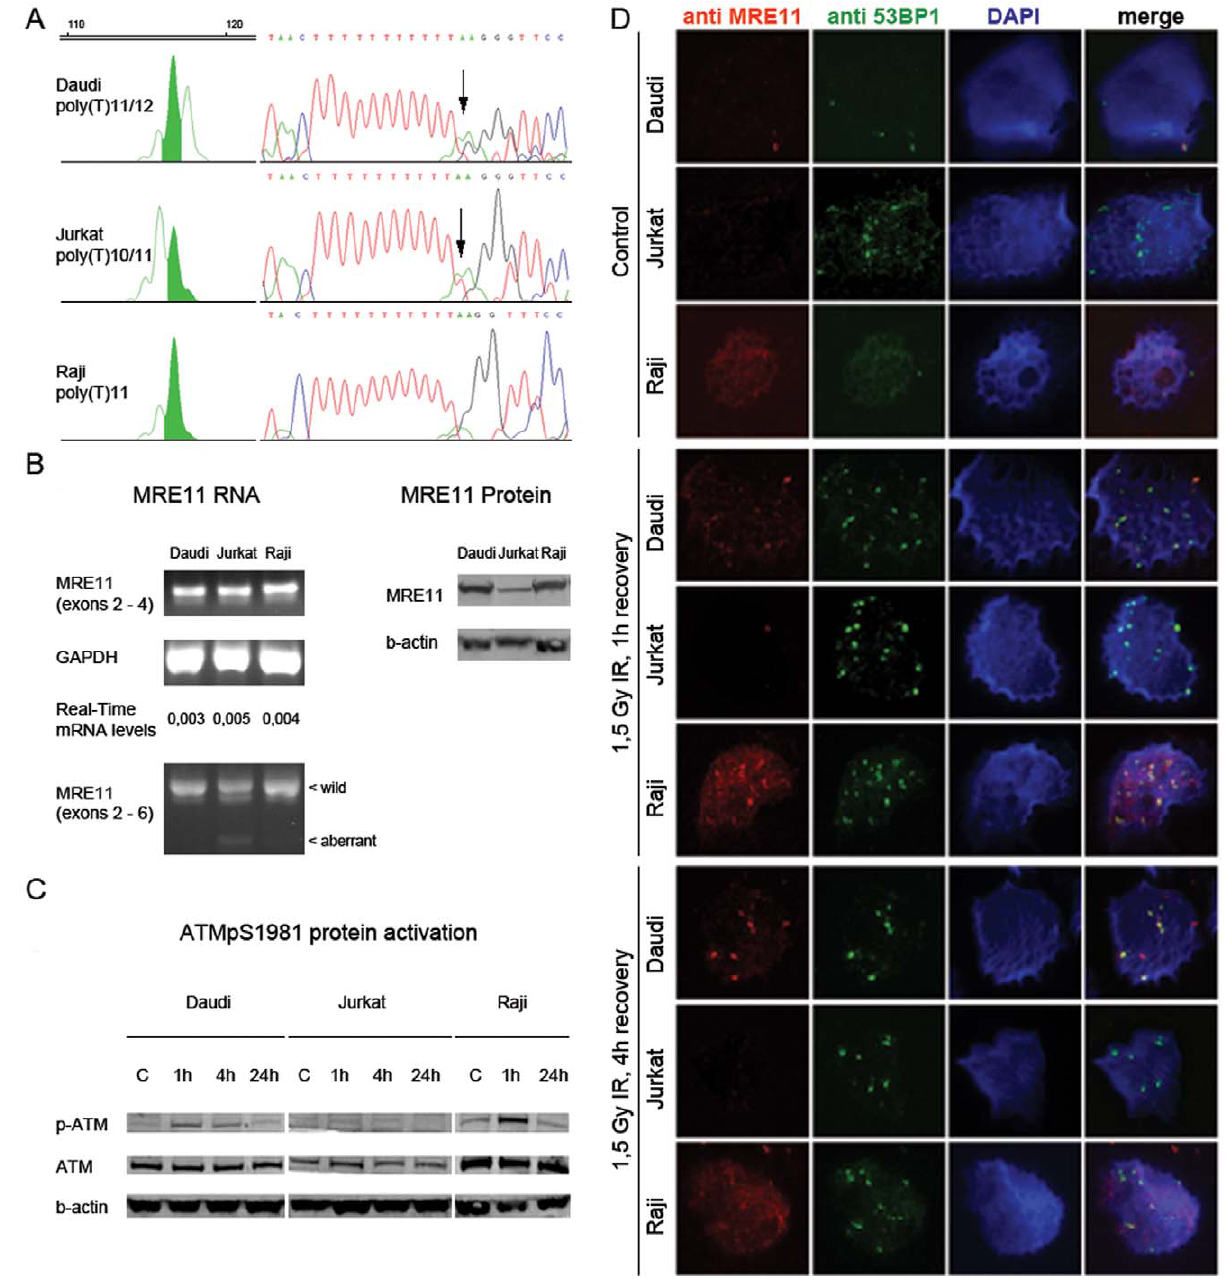
Figure 4. MRE11poly(T)11/12sequencevarianthasnoapparentfunctional consequence on DNA damage detection and repair. (A) Electropherograms and sequencing traces of the MRE11 poly(T)11 tract in leukemia/lymphoma cells: Daudi (heterozygous insertion of one bp, poly(T)11/12); Jurkat (heterozygous deletion of one bp, poly(T)10/11); and Raji (wild-type, poly(T)11). (B) MRE11 expression in Daudi, Jurkat and Raji cells. qRT-PCR was used to calculate the ratio of MRE11 expression (amplification of exons 2 to 4) relative to the GAPDH control, independently of the presence of the aberrant transcript observed in Jurkat. PCR products were loaded on the gel at saturation of the reaction, being not quantitative. MRE11 protein levels were assessed by Western blot, and were considerably lower in Jurkat. (C) ATM-pS1981 levels were assessed by Western blot in Daudi, Jurkat and Raji after 1.5 Gy irradiation of cells and 1 h, 4 h or 24 h recovery. There was an increase of ATM phosphorylation 1 h after irradiation in Daudi and Raji cells that decreased at the later time points. Jurkat showed no ATM phosphorylation after exposure to irradiation. (D) DNA repair foci was observed by immunofluorescence after 1.5 Gy IR followed by 1 h and 4 h recovery. Irradiation resulted in the formation of both MRE11 and 53BP1 foci in Daudi and Raji cells, whereas Jurkat failed to form MRE11 foci. Nuclei were counterstained with DAPI. Merged figure presents co- localization of MRE11 and 53BP1 foci visualized in yellow. doi:10.1371/journal.pone.0020588.g004 MSH6 expression was absent in a single sample that also expression, molecular deficiencies in this gene appear to be the presented a homozygous insertion of a single nucleotide in origin of the MSI phenotype in most of the cases, although we did the poly(C)8 track of MSH6 , which is a target of MSI. This not observe point mutations or hypermethylation in these samples.